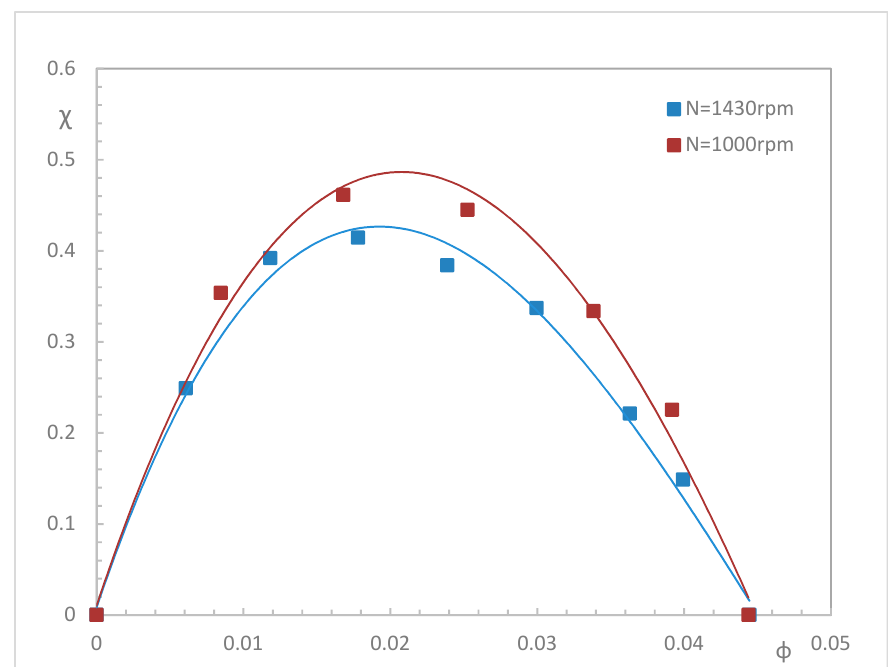
Figure 8. Experimental fluid power versus flow coe ffi cients for two rotational